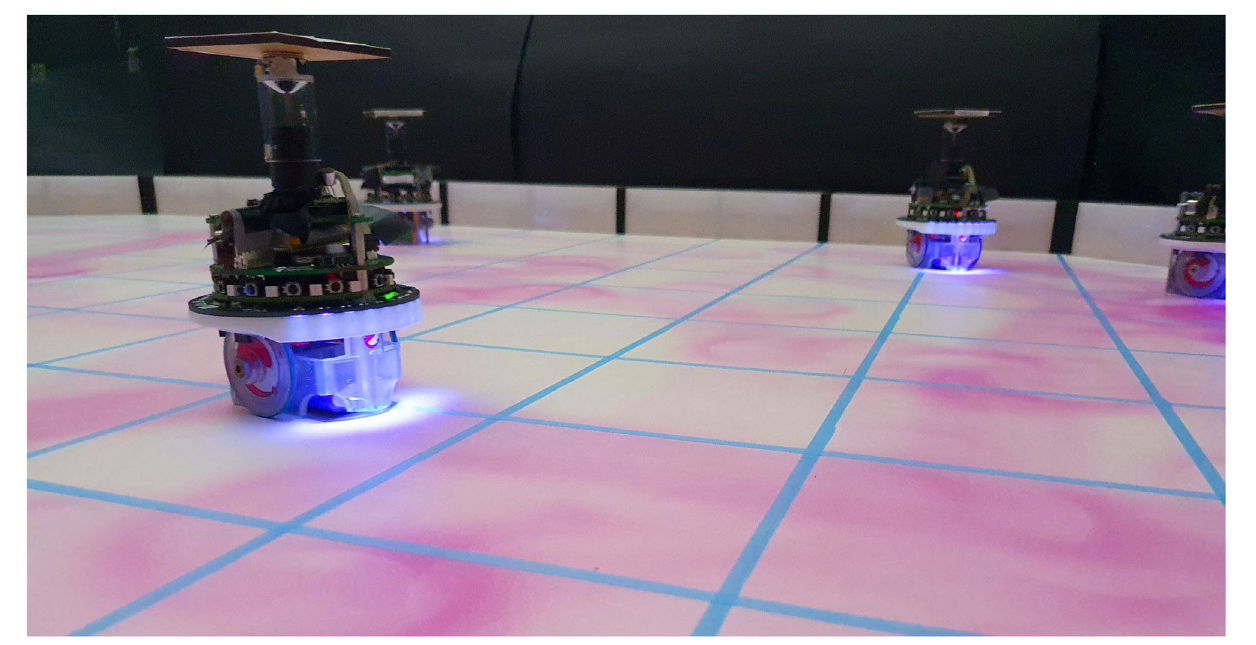
FIGURE 3 | A swarm of e-puck robots equipped with UV-pheromone-module and omni-directional camera releases pheromone in the artificial pheromone environment to accomplish a collective